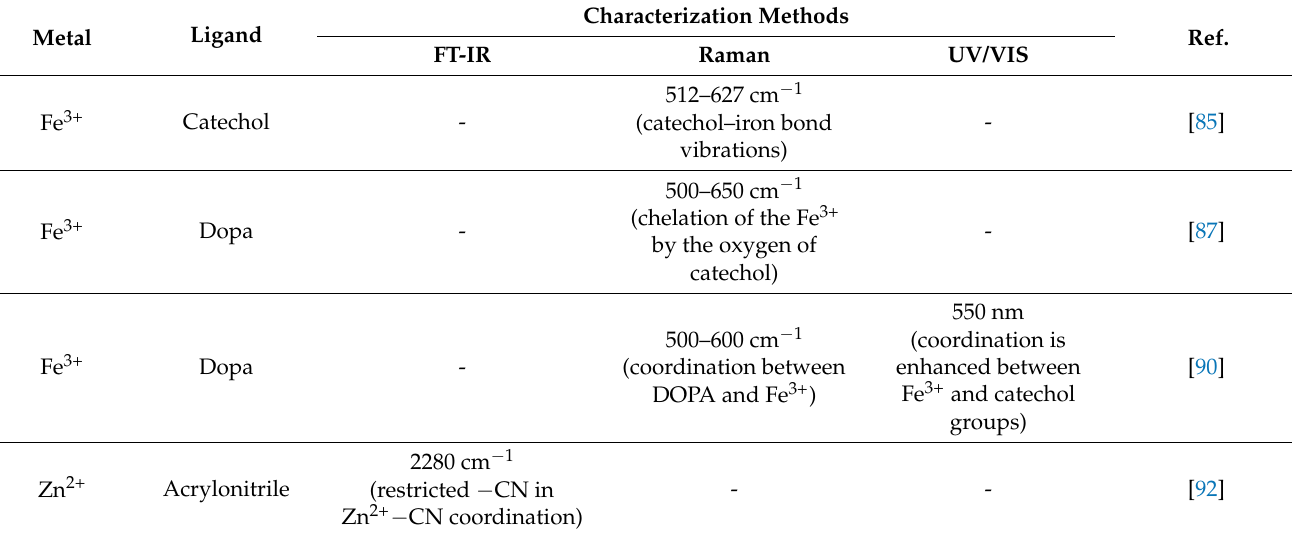
Table 2. Overview of characterization methods for metal–ligand coordination.